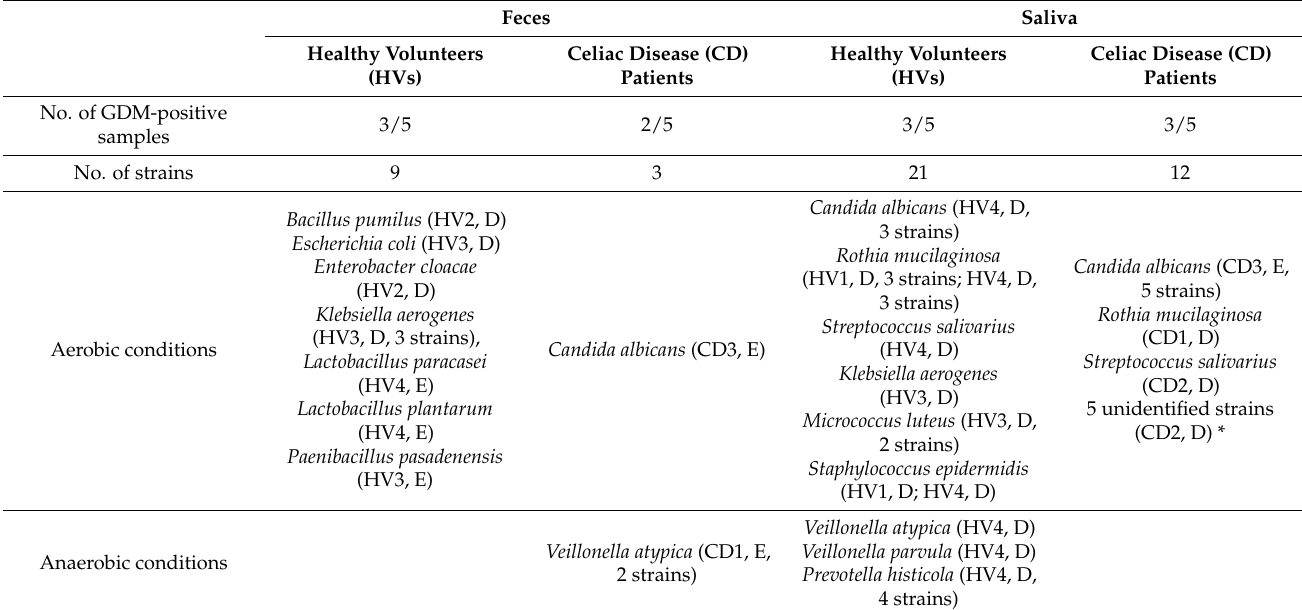
Table 1. An overview of the isolated gluten-degrading microorganisms under different conditions. Feces Saliva Healthy Volunteers Celiac Disease (CD) Healthy Volunteers Celiac Disease (CD) (HVs) Patients (HVs)